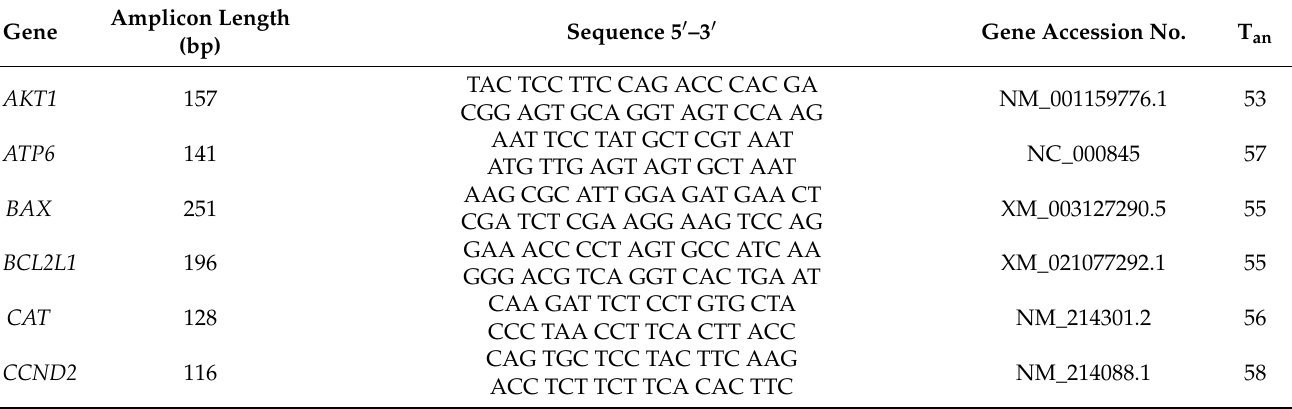
Table 6. List of primers used for